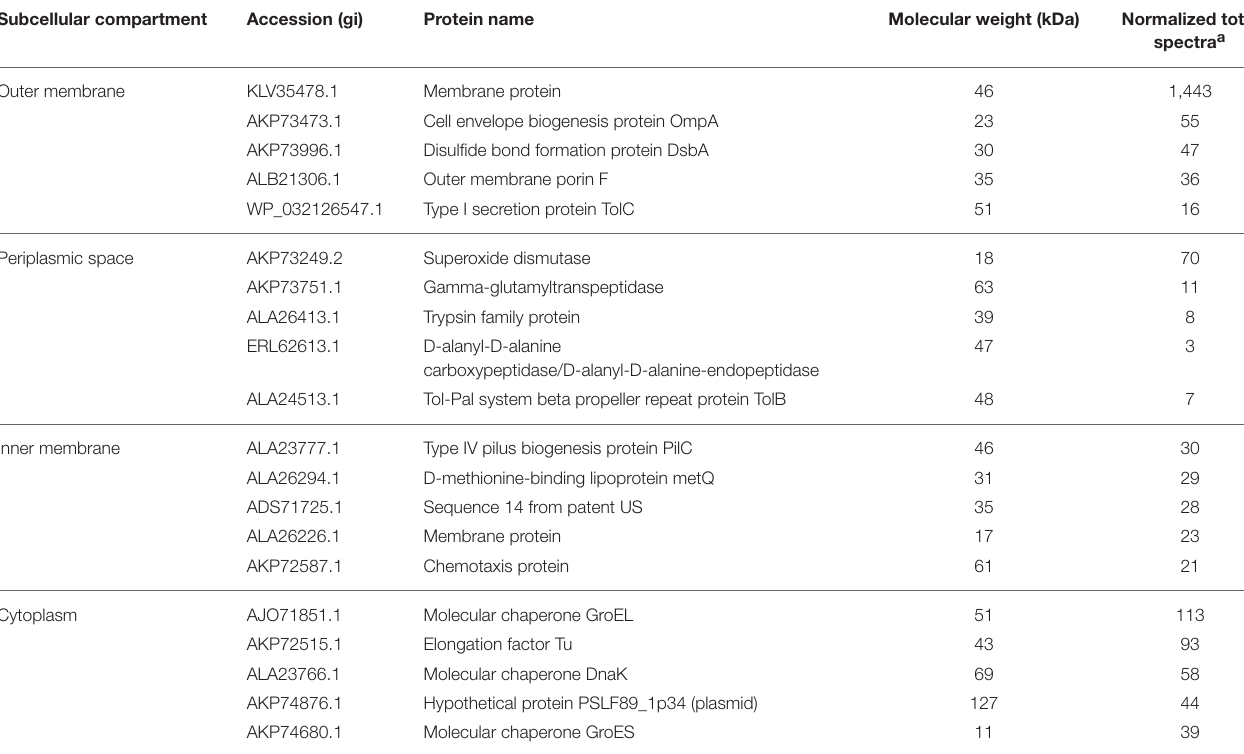
TABLE 2 | Five most abundant proteins from each subcellular compartment identified in P. salmonis LF-89 type strain membrane vesicles. Subcellular